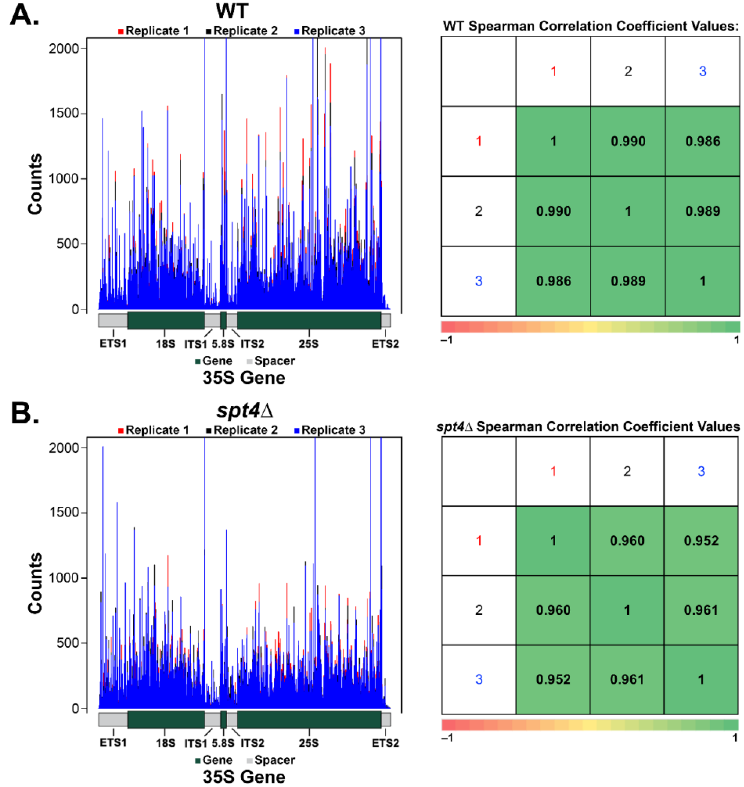
Figure 1. NET-seq experiments are reproducible for WT and spt4 (cid:52) yeast strains. Three libraries for each strain were prepared and sequenced. The reads were mapped back to the yeast genome, and were plotted in ( A , B ). Spearman correlation coefficient values were calculated comparing each of the three replicates against the other two per strain. A coefficient value of 1 indicates complete similarity between the two replicates (as can be seen when comparing one replicate against itself); whereas a value of − 1 indicates completely opposite rank